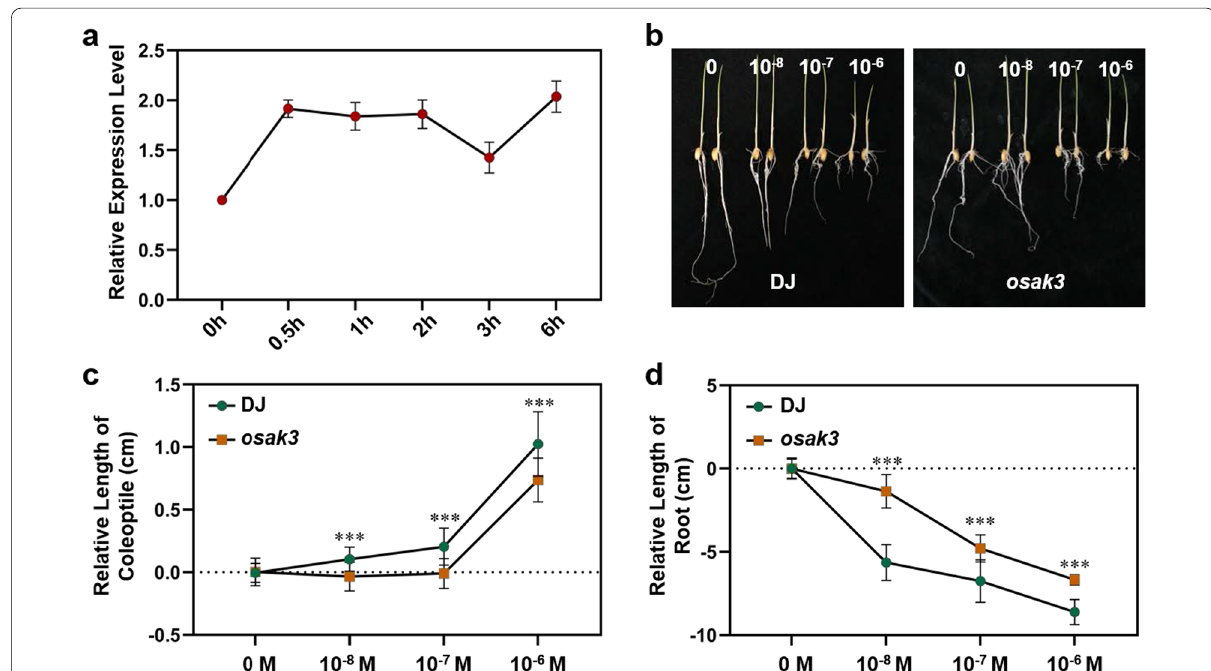
Fig. 4 OsAK3 is involved in rice brassinosteroid signaling. a RT-qPCR analysis of OsAK3 expression under 10 –6 M BL treatment. Data are means ( n 3). b Coleoptile elongation analysis and root inhibition analysis of DJ and osak3 mutant in response to 0 M, 10 –8 M,10 –7 M and 10 –6 M BL. c = Statistical data of coleoptile elongation analysis in DJ and osak3 mutant. The data was analyzed with the relative coleoptile length between BL treatment and mock. Data are means SD ( n 20). Statistical analyses were performed by student’s t test. *** P value < 0.001. d Statistical data of ± = root inhibition analysis in DJ and osak3 mutant. The data was analyzed with the relative root length between BL treatment and mock. Data are means SD ( n 20). Statistical analyses were performed by student’s t test. *** P value < ± =